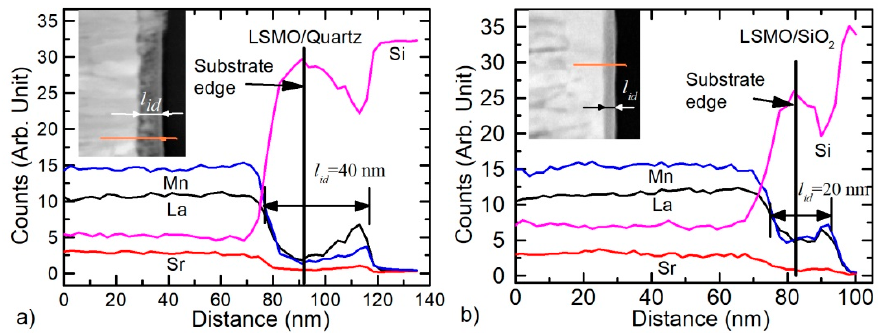
Figure 4. Normalized TEM-EDS line profiles of the elements of 360 nm-thick LSMO films grown on quartz ( a ) and Si/SiO 2 ( b ) substrates. Insets—cross-sectional STEM Z-contrast image with marked scanning lines.